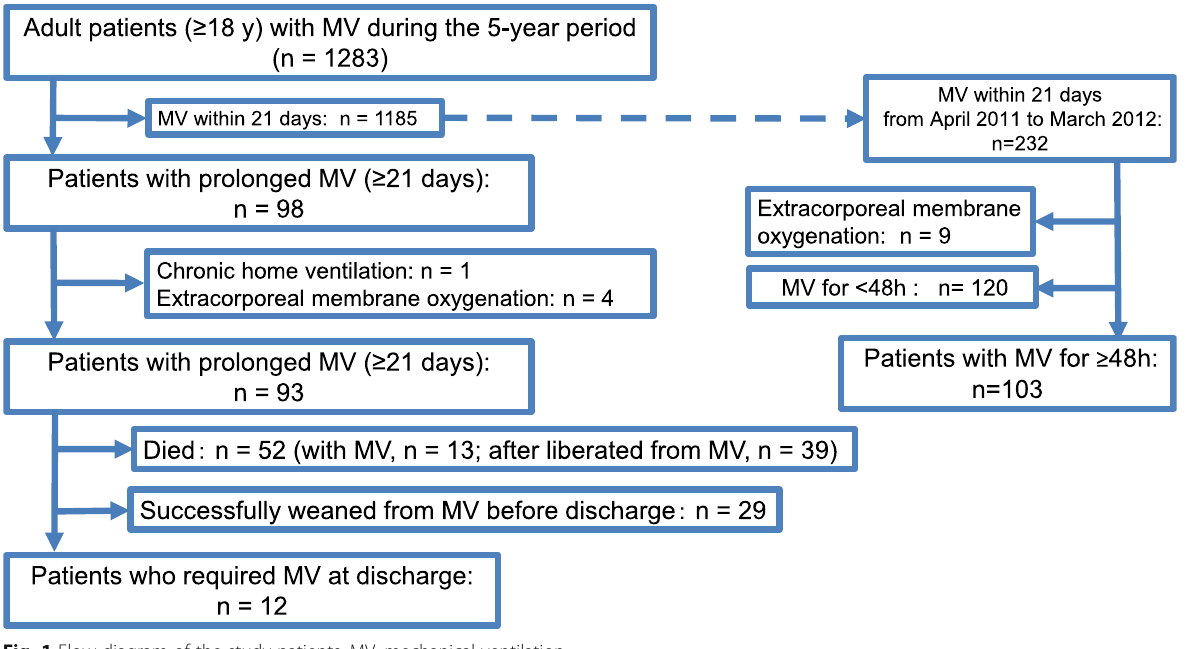
Fig. 1 Flow diagram of the study patients. MV, mechanical